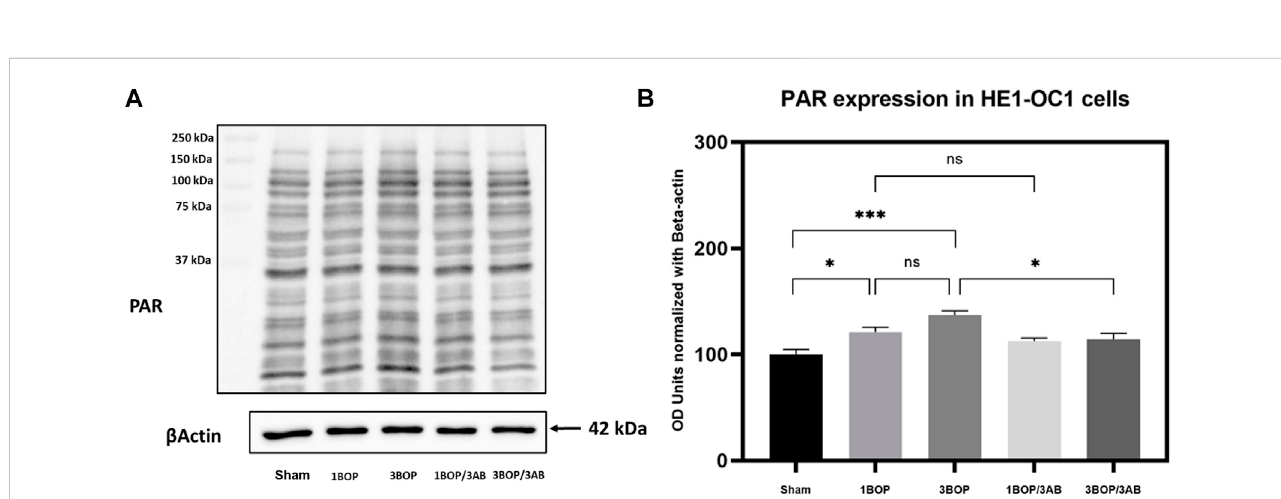
FIGURE 7 AssessmentofPARproteinexpressionsbyimmunoblottinganalysisinHEI-OC1afterBOPexposure.The (A) immunoblotsshowstheproteinexpressions ofPARlevelsinHEI-OC1cells. (B) Thehistogramshlesemi-quantitativeproteinexpressionofPARlevels inHEI-OC1cells normalizedagainst theinternalcon ES-Actin. Statistical difference between the cell groups were (* p < 0.05; ** p < 0.001) represented as Mean ± SEM ( n =